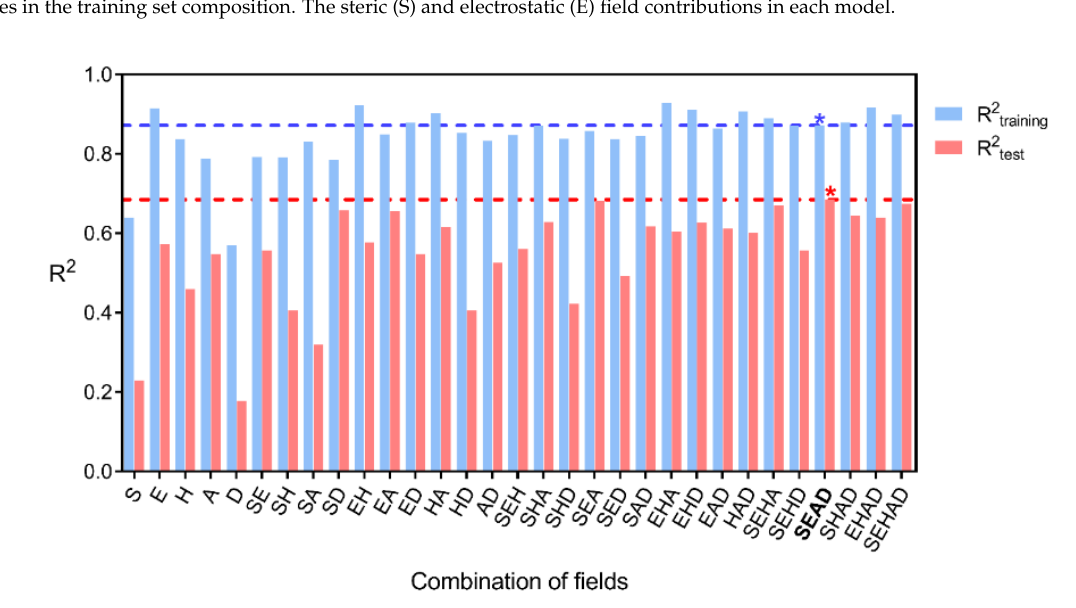
Figure 2. The results of the distribution of R 2test values were obtained from 31 combinations of Gaussian fields. S, steric; E, electrostatic; H, hydrophobic; A, hydrogen-bond acceptor; D: hydrogen-bond donor. The best Gaussian fields combination is highlighted with an asterisk on the bars with R 2training 0.898 and R 2test 0.695.